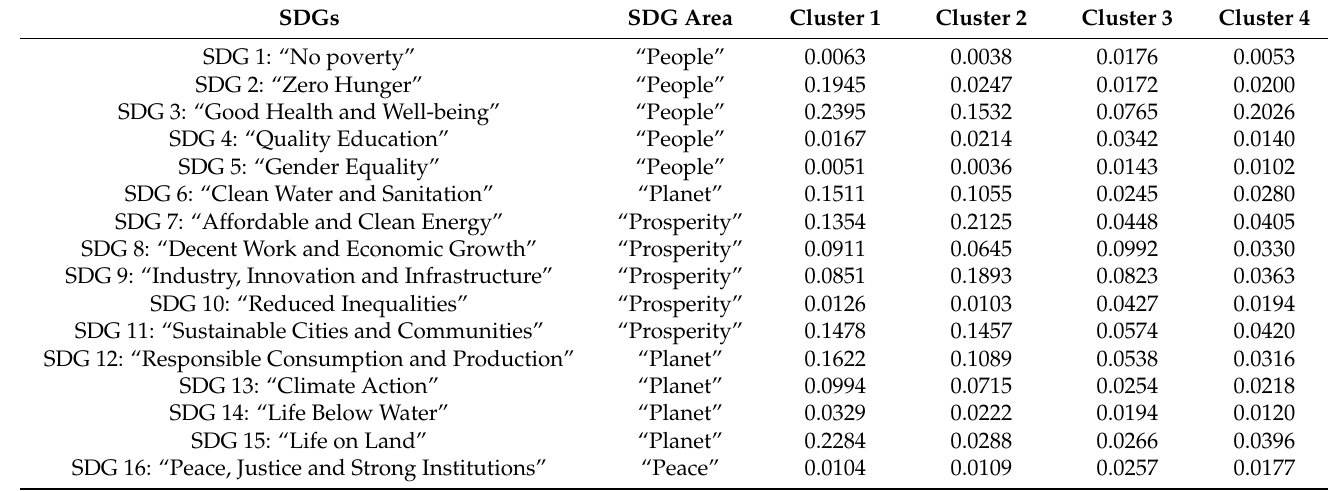
Table 5. Cluster characteristics based on average publication productivity in promoting individual SDGs in